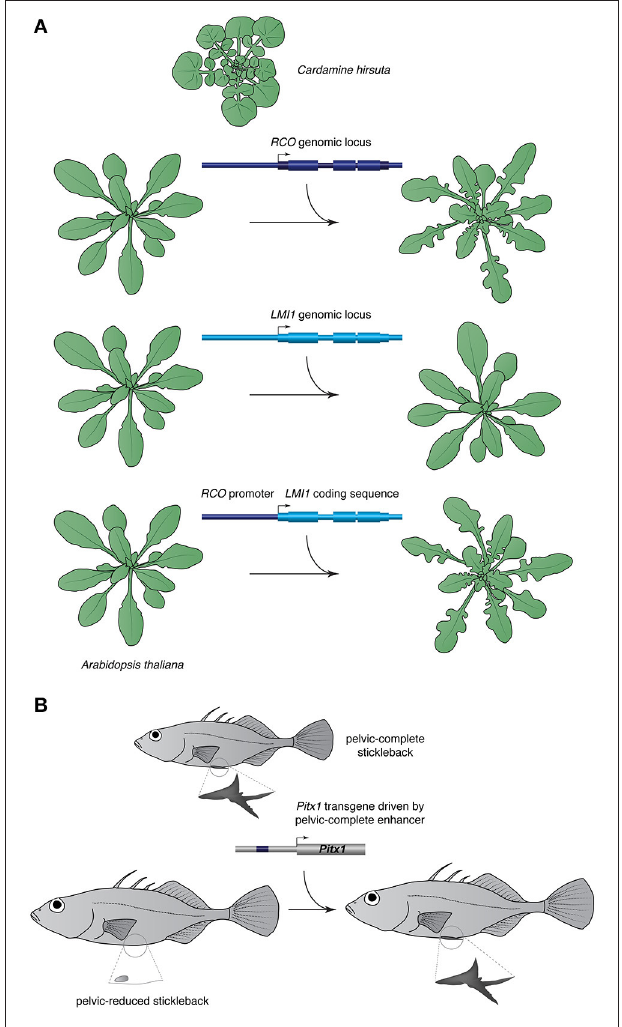
FIGURE 2 | Examples of IGT. (A) RCO affects leaf morphology and a copy of the gene from the compound leaved mustard Cardamine hirsuta is able to transform the simple leaves of Arabidopsis thaliana into complex lobed leaves. A genomic locus of the paralog of RCO , LMI1 , transformed in A. thaliana is not able to modify leaf morphology but plants expressing LMI1 driven by the RCO promoter have lobed leaves, suggesting regulatory divergence of the two paralogs. (B) Pitx1 enhancer affects pelvic morphology in sticklebacks; transfer of the enhancer and coding sequence of pelvic-complete stickleback into a pelvic-reduced stickleback results in pelvic expression and